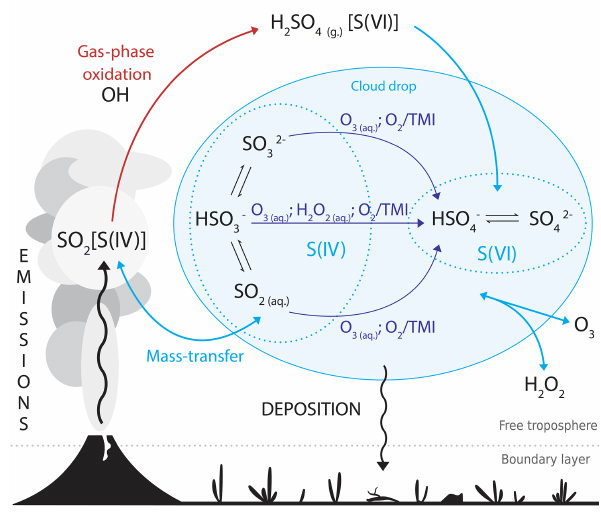
Figure 1. Diagram of the new sulfur scheme implemented in CiT-